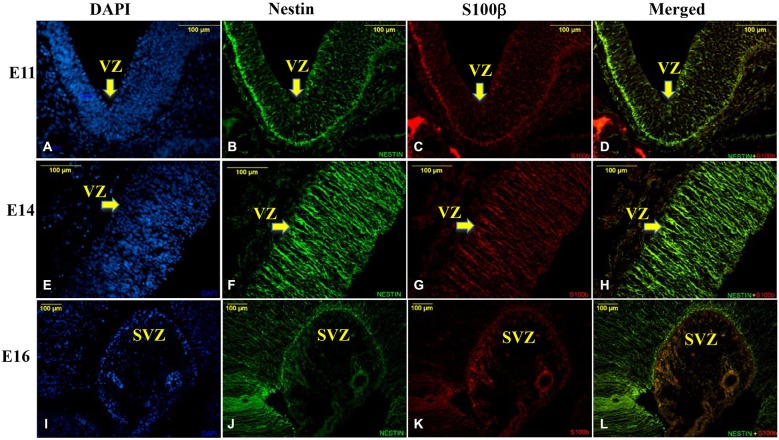
S100β labels both primary and secondary progenitors at VZ and SVZ during early embryonic life. Sagittal sections through the developing forebrain were co-immunostained with antibodies against Nestin (green) and S100β (red). All the progenitors lining VZ and SVZ were strongly positive for Nestin (B,F,J) and S100β (C,G,K). A strong co-localization of both the markers was detected at VZ (D,H) and SVZ (L) zones. DAPI (blue) clearly indicated the brain areas focused (A,E,I).